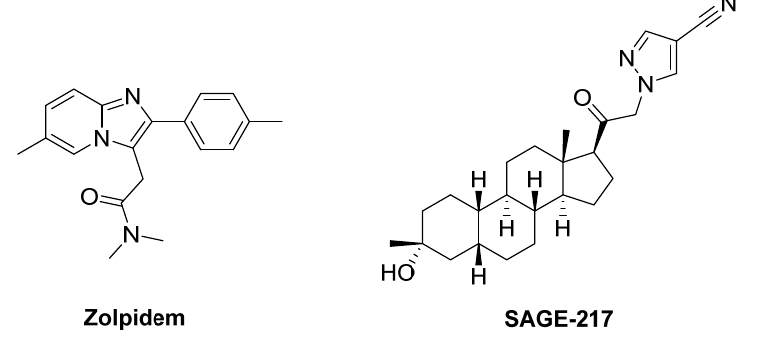
Figure 15. GABA receptor ligands.